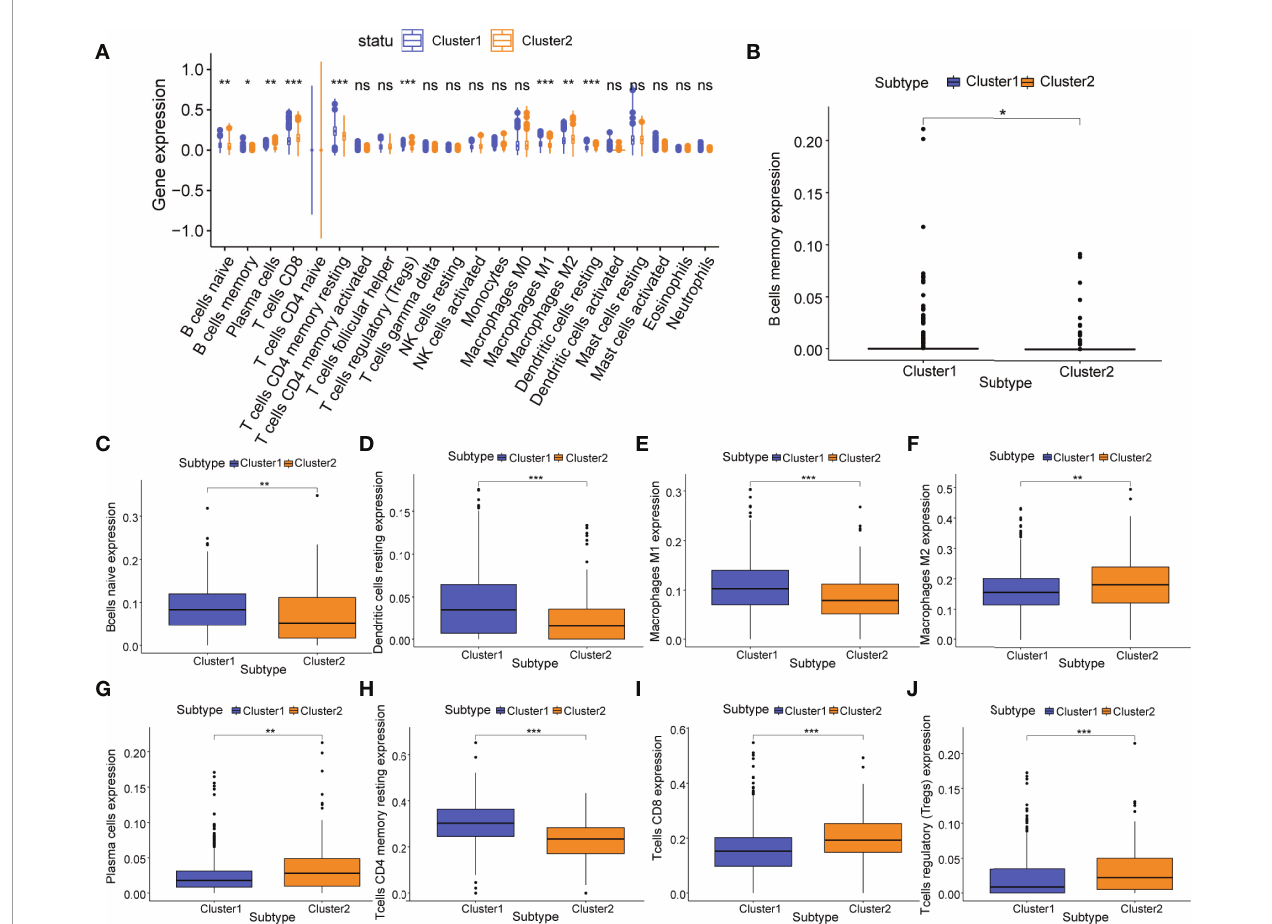
FIGURE 7 | Relationship of m5C regulatory gene clusters and tumor immune in fi ltration. (A) Abundance of 22 in fi ltrating immune cell phenotypes in m5C regulatory gene cluster 1 (cluster 1, blue) and m5C regulatory gene cluster 2 (cluster 2, yellow). Differences in the abundance of 9 in fi ltrating immune cell phenotypes including (B) memory B cells; (C) naive B cells; (D) resting dendritic cells; (E) M1 macrophages; (F) M2 macrophages; (G) plasma cells; (H) resting CD4+ T cells; (I) CD8+ T cells; and (J) Tregs in m5C regulatory gene cluster 1 (cluster1, blue) and m5C regulatory gene cluster 2 (cluster2, yellow). P-values were shown as follows: ns, not signi fi cant, * P < 0.05; ** P < 0.01; *** P <